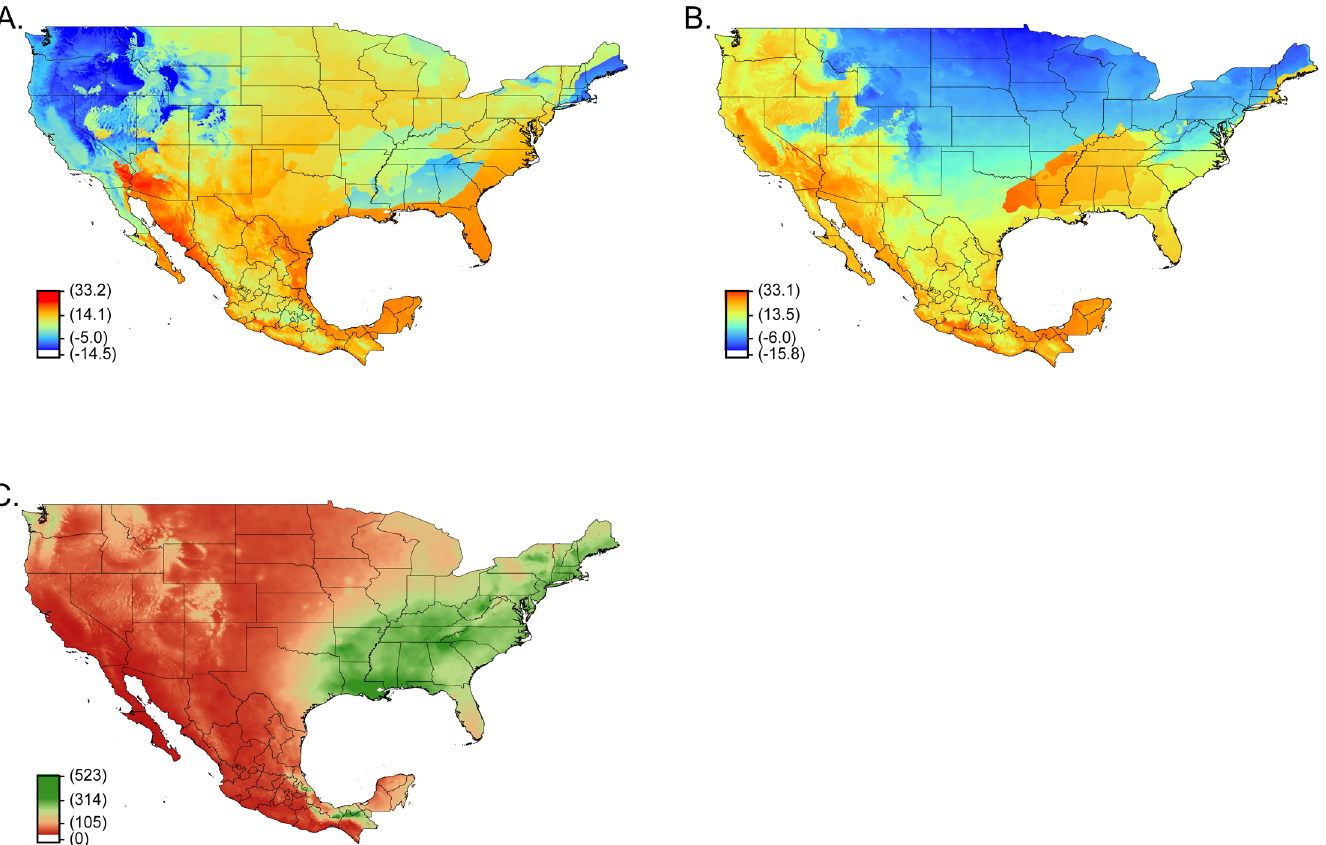
Fig 4. Environmental variables that may explain the gap between populations of O . turicata in Florida and Texas. Shown are mean temperature of the wettest quarter (BIO8) (A), mean temperature of driest quarter (BIO9) (B), and precipitation of the driest quarter (BIO17) (C). The gradient of red to blue represents high to low temperatures (°C) (A – B). For the precipitation variable, a gradient of green to dark brown represents the amount of high to low precipitation (mm)